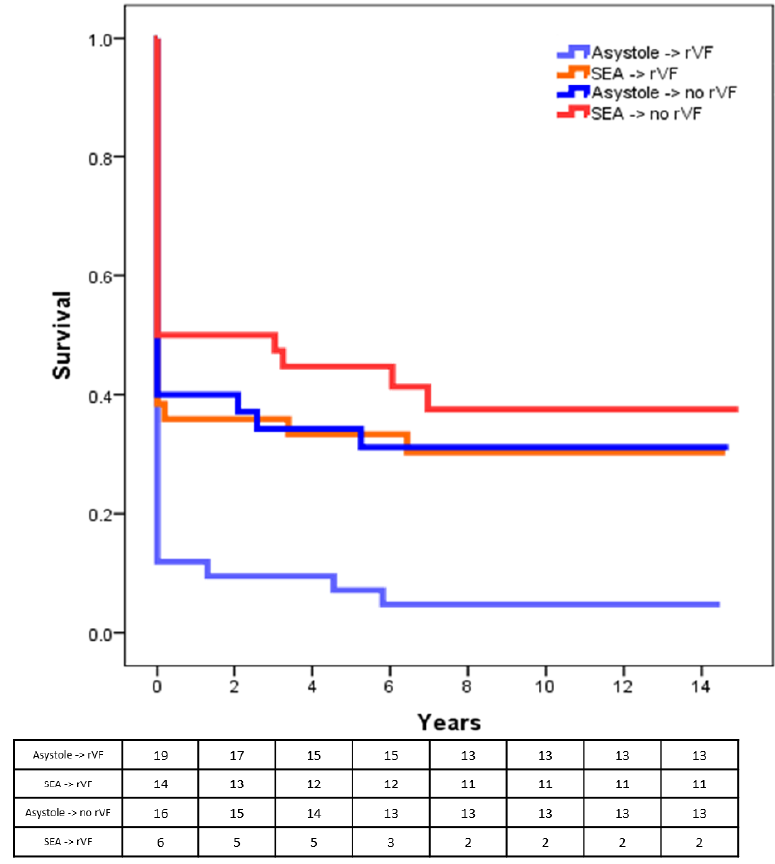
Figure 4. Long-term survival according to post-shock rhythm and rVF. rVF: recurrent VF; SEA: spontaneous electrical activity.